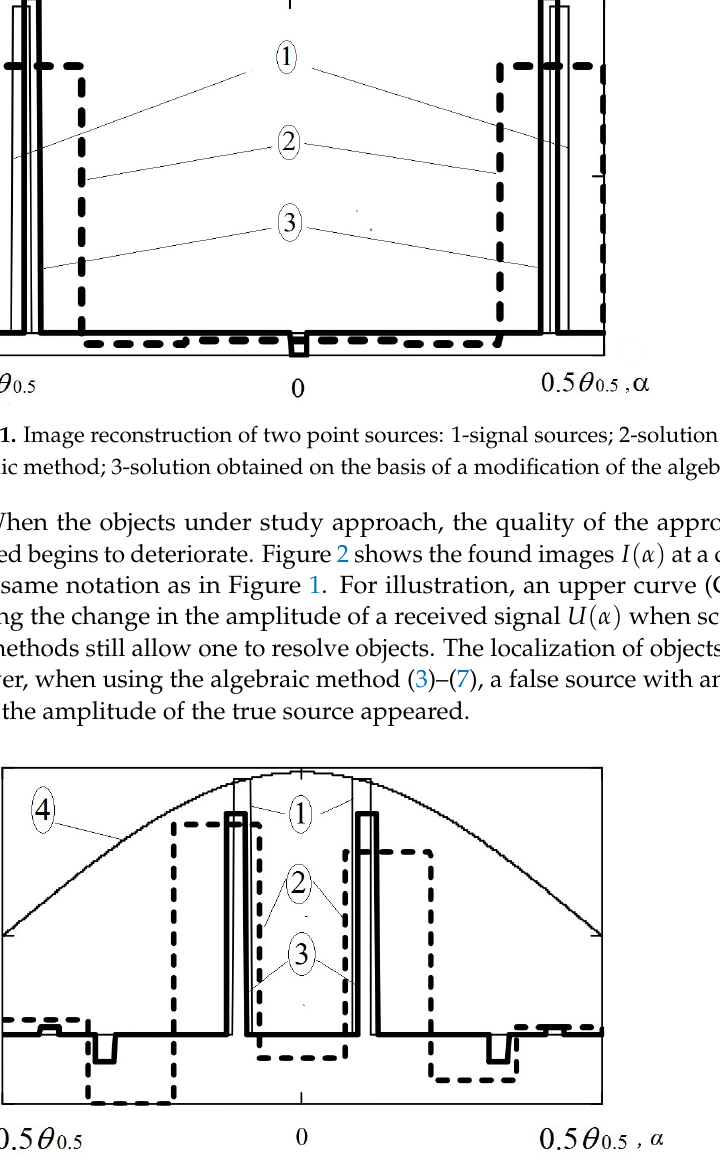
Figure 2. Image reconstruction of point sources at a distance of 0.2 θ 0.5 : 1-signal sources; 2-solution found by the usual algebraic method; 3-solution obtained on the basis of a modification of the algebraic method; 4-change in the amplitude of a received signal U ( α ) when scanning the